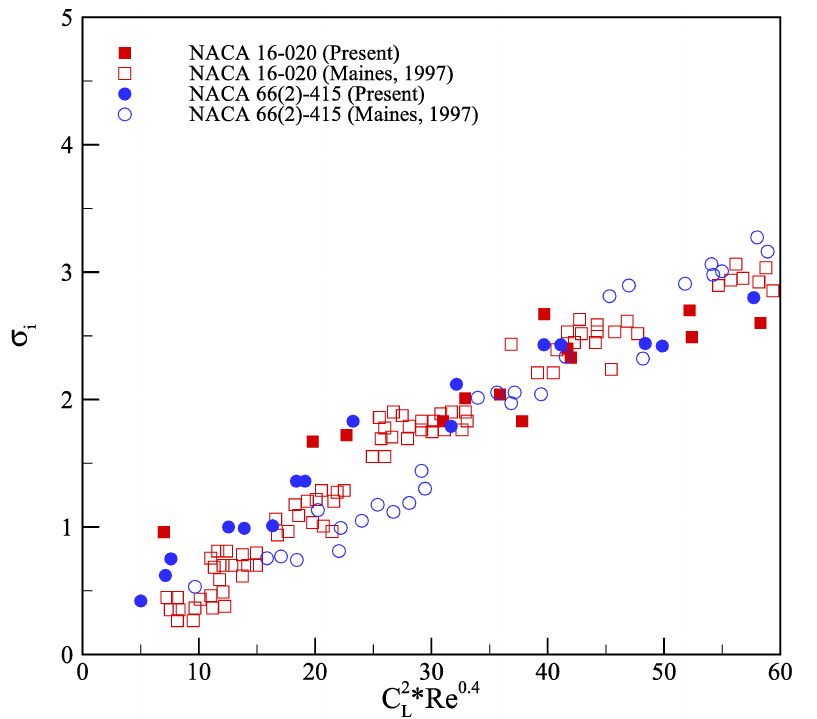
Figure 6. Cavitation inception scaling with the measured lift coefficient, C L and Reynolds number, Re